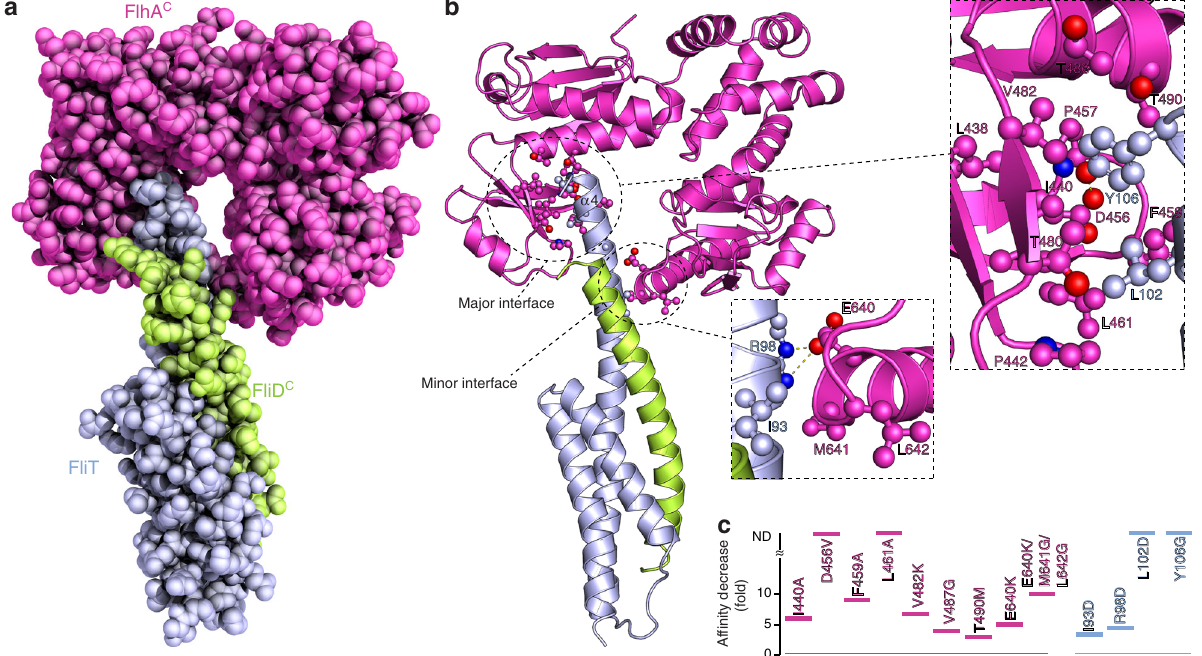
Fig. 3 Structure of the FlhA C − FliT − FliD C ternary complex. a Crystal structure of the ternary complex shown as a space- fi lling model. b Cartoon rendering of the structure and expanded views of the two interfaces, major and minor, between FlhA C and FliT. Residues participating in intermolecular contacts are shown as ball-and-stick. Hydrogen bonds and salt bridges are shown as broken lines. c Effect of the indicated amino acid substitutions on the af fi nity of FlhA C for FliT − FliD C . The effect is given as a fold decrease relative to the af fi nity of the wild-type proteins ( K d ~20 μ M; Supplementary Fig. 4d). Non- detected binding is indicated as